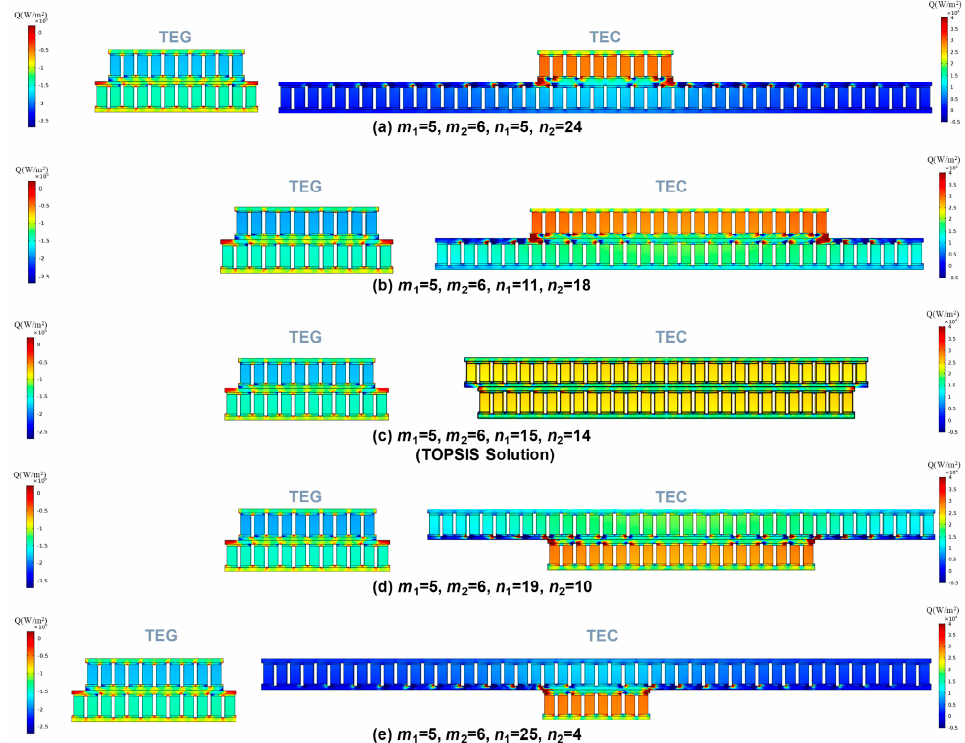
Figure 15. Heat flux distribution of the structures with n 1 = 5, 11, 15, 19, and 25, corresponding the results shown in Figure 13a.